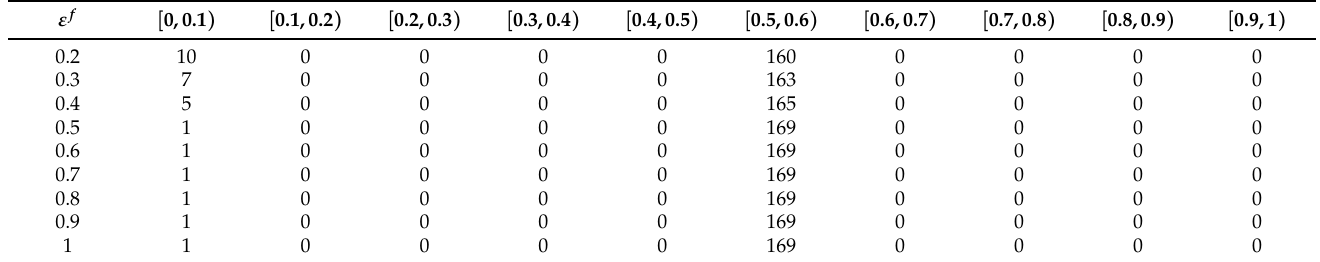
Table 4. Number distribution of all individuals in different ranges when ε f = 0.4 and ε l vary in [ 0,1 ] .